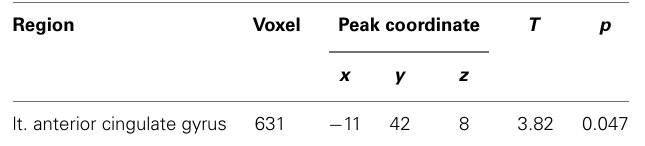
Table 2 |Talairach coordinates for regions of reduced gray matter volume in the schizophrenia patients compared to the healthy